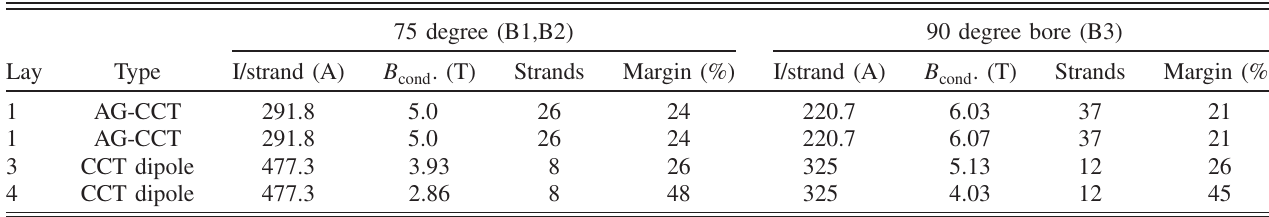
TABLE VIII. Short sample at highest magnet current.